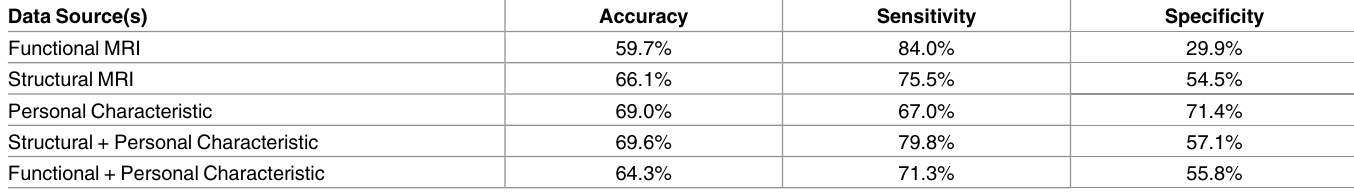
Table 15. ADHD-200results summary.